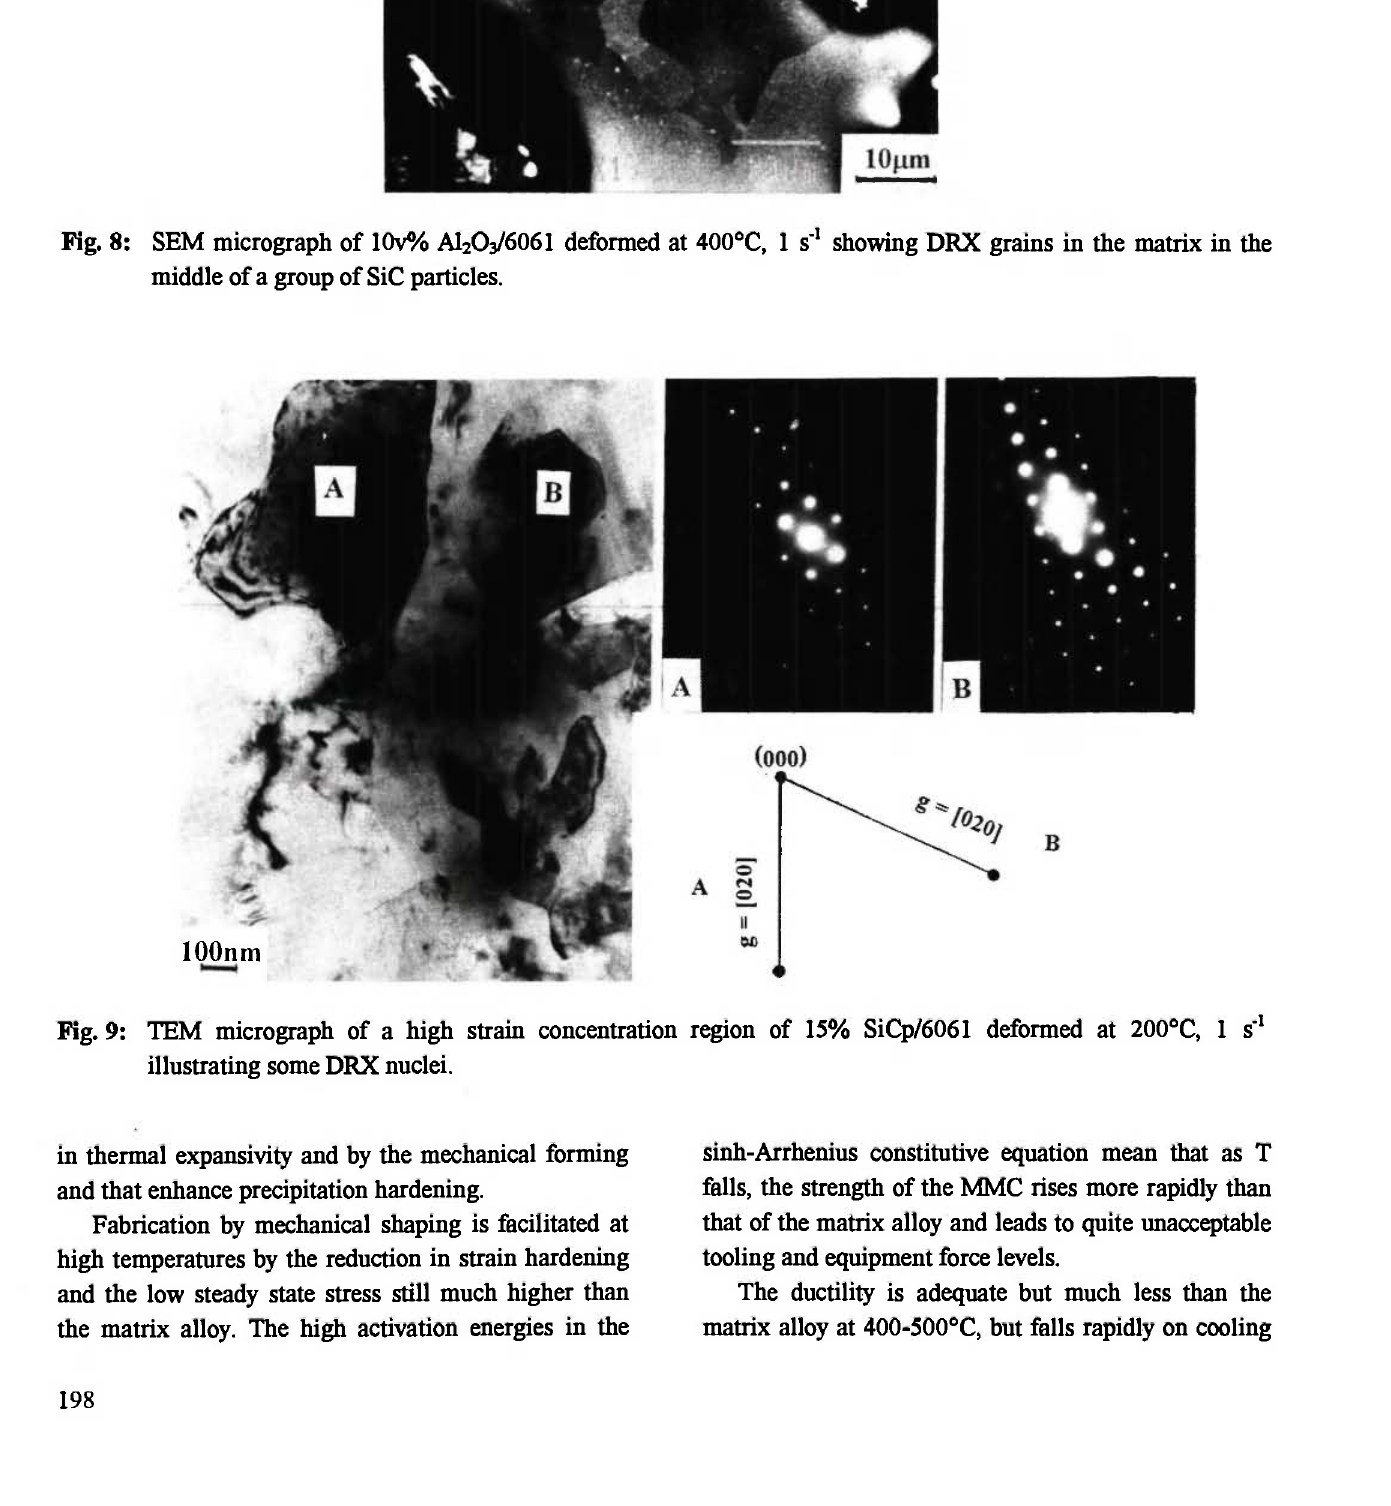
Fig. 8: SEM micrograph of 10v% A1 2 0j/6061 deformed at 400°C, 1 s" 1 showing DRX grains in the matrix in the middle of a group of SiC particles.